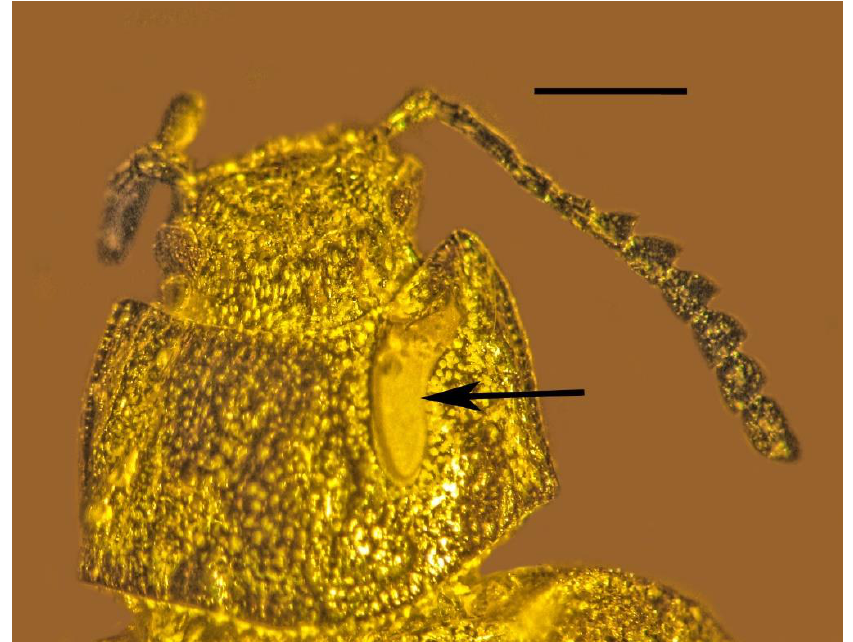
Figure 18. Tachinid egg (Diptera: Tachinidae) (arrow) attached to the pronotum of the leaf beetle Stenaspidiotus microptilus (Coleoptera: Chrysomelidae) in Dominican amber. Scale bar = 750 µm. Fossil evidence of beetle predation is quite rare, so it was a surprise to find a platypodine under attack by a reduviid bug (Hemiptera: Reduviidae) in Dominican amber (Figure 19). Another case of predation involved the beetle as the predator. This was a meloid (Coleoptera: Meloidae) triungulin just above the “neck” of a stingless bee (Hymenoptera: Apidae) in Dominican amber (Figure 20). When carried back to the hive, the triungulin will devour the developing bee stages [16].